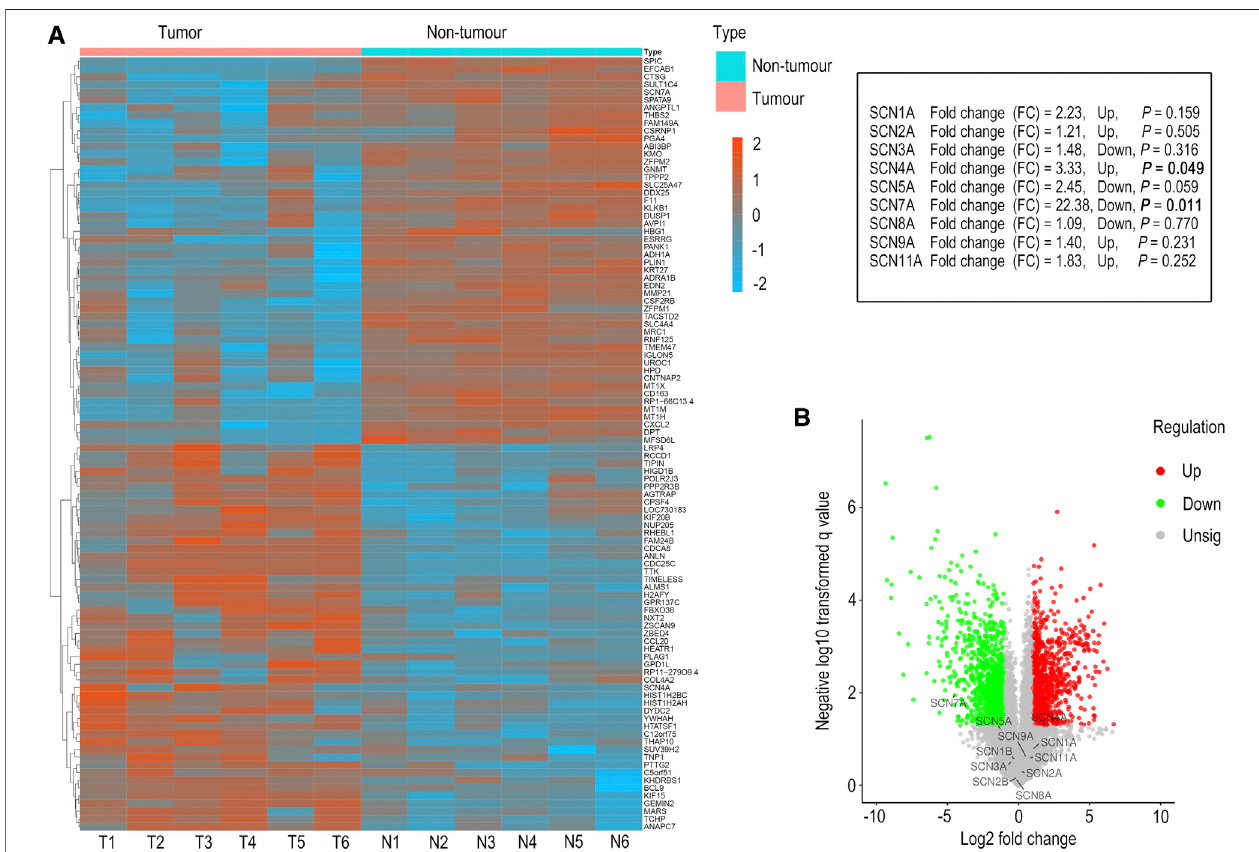
FIGURE2| MicroarrayanalysisofHCCtissuesandadjacentnon-tumourtissues. (A) Thegeneswithsigni fi cantchangesinexpressioninHCCtissuesandadjacent non-tumour tissues are shown in the hierarchical clustering heatmap. (B) All the genes in HCC tissues and adjacent non-tumour tissues are shown in the volcano plot.